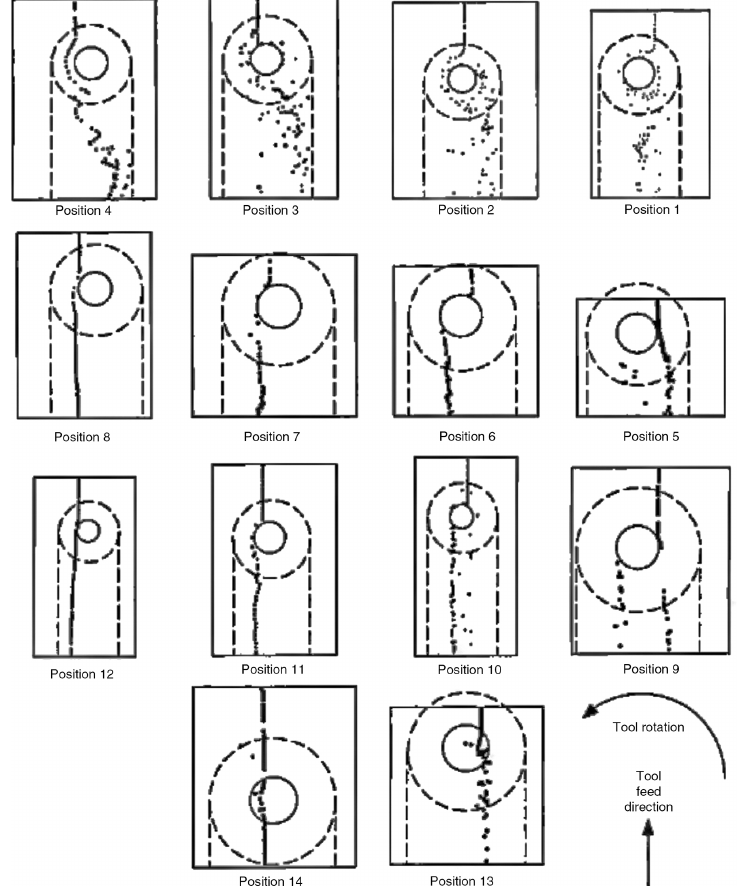
Figure 7: Drawings generated from each of the plan view radiographs for the 6061 welds are shown here. The positions are defined relative to the welding tool path in Figure